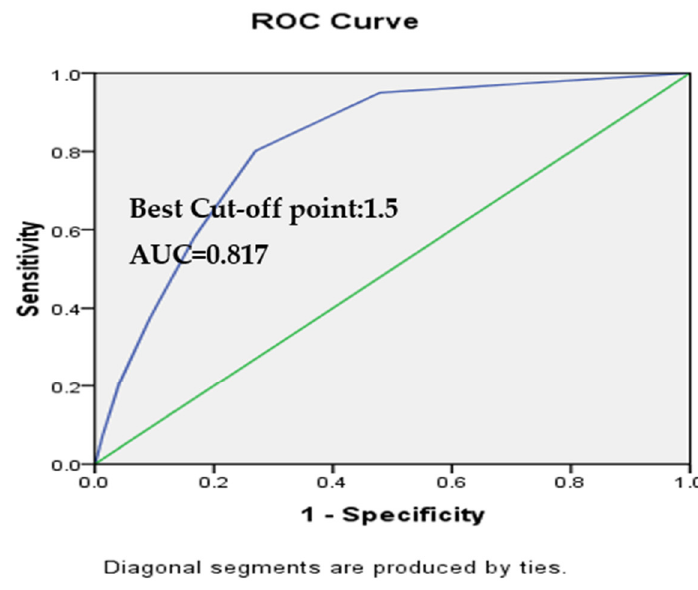
Table 2. The Best Tangent Point for Fall Risk Factor Assessment Scale Score.